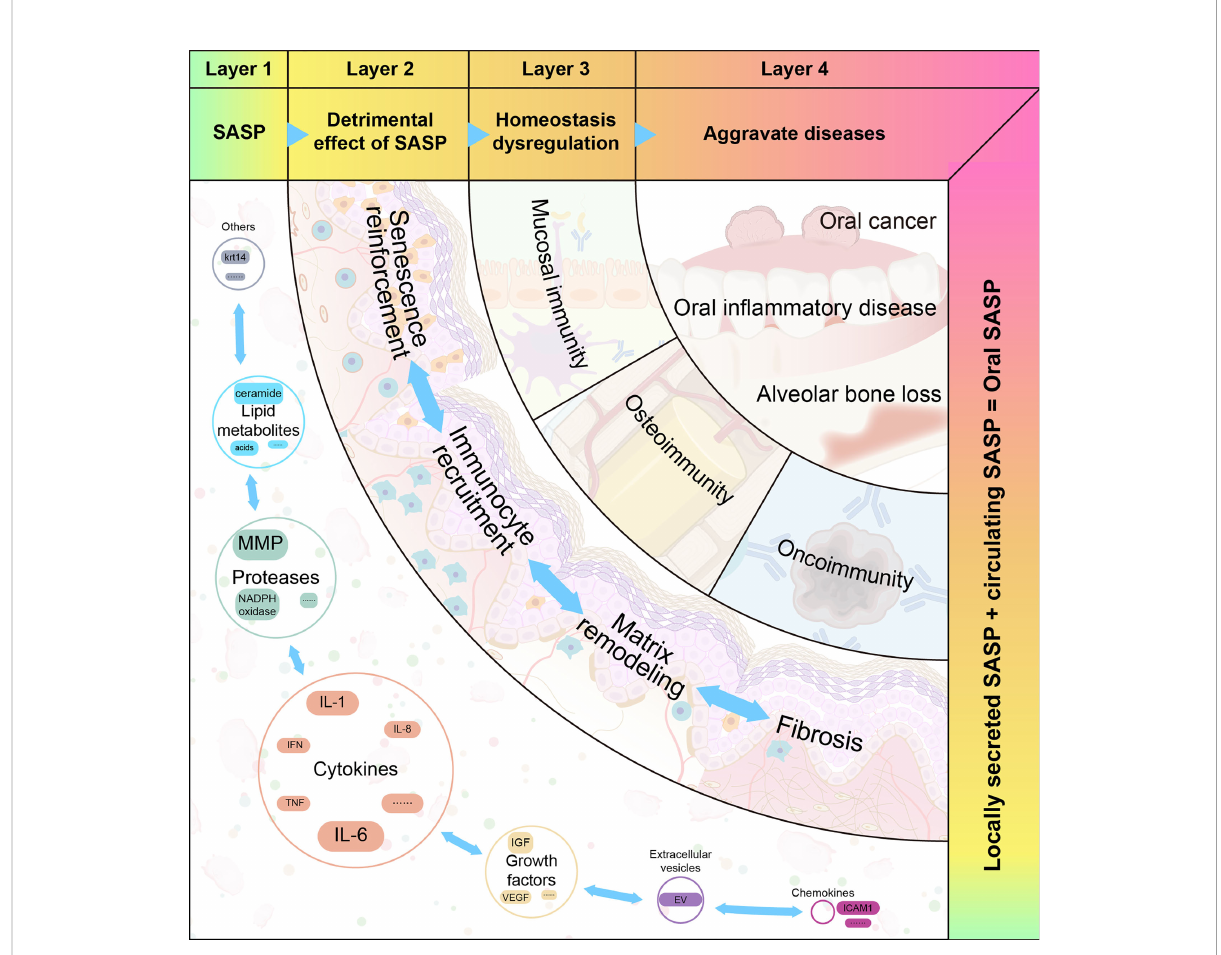
FIGURE 3 The four proposed layers of how senescence-associated secretory phenotype impacts oral diseases. Senescence-associated secretory phenotype (SASP) (including cytokines, chemokines, growth factors, and proteases) secreted by oral senescent cells, as well as circulating SASP, constitute the aging microenvironment of oral cavity. As an important mediator, SASP accelerates oral pathological alterations including senescence re-enforcement, recruitment of immune cells, matrix remodeling and fi brosis. Then, the SASP-induced dysregulation of immune homeostasis can be divided into three categories: mucosal immunity, bone immunity, and tumor immunity. These destroy the structure and function of different oral tissues. When age-related tissue damage accumulates, it manifests as age-related